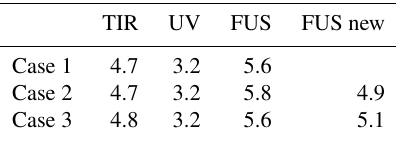
Table 1. Number of DOF of the profiles obtained with the TIR mea- surement, the UV measurement, the original fusion method and the modified fusion method for each of the three cases described in Sect.